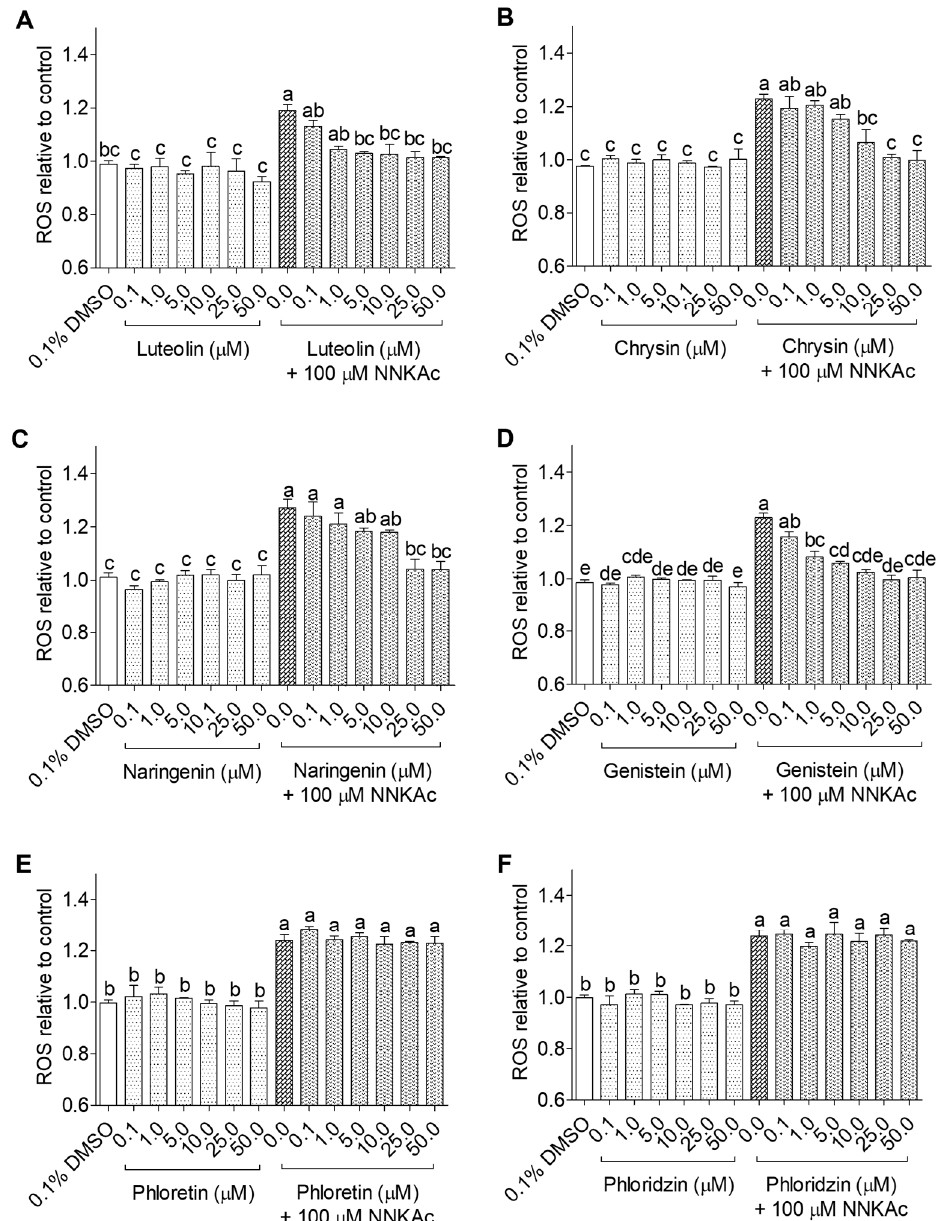
Figure 2. Effect of luteolin ( A ), chrysin ( B ), naringenin ( C ), genistein ( D ), phloretin ( E ), and phloridzin ( F ) on reducing NNKAc-induced ROS in BEAS-2B cells. Cells were pre-treated with concentrations ranging from 0.1 to 50 µM of selected 3-deoxy flavonoids and chalcones for 3 h. Pre-treated cells were exposed to 100 µM NNKAc for another 3 h to induce ROS generation. DMSO (0.1%) was used as the vehicle control. Effects on ROS levels were quantified using DCFDA fluorescence assay. Two independent studies ( n = 3) were performed, and results were expressed as mean ± standard deviation. Statistical analysis of data was performed by one-way ANOVA and mean comparison was done by Tukey’s mean comparison method ( α = 0.05) using Minitab 19 statistical software (LLC, Pennsylvania, USA). Mean values that do not share similar letters in bar graphs are significantly different ( p < 0.05). Abbreviations: NNKAc: 4-[(acetoxymethyl)nitrosamino]-1-(3-pyridyl)-1-butanone, DCFDA: 2 ′ 7 ′ -dichlorofluorescein diacetate, ROS: reactive oxygen species, DMSO: dimethylsulfoxide. Among the tested flavonoid metabolites, isorhamnetin at 50 µ M significantly reduced ( p < 0.05) ROS levels induced by NNKAc in BEAS-2B cells (Figure 3). BEAS-2B cells pretreated with curcumin (5–50 µ M), resveratrol (10–50 µ M), and catechol (25–50 µ